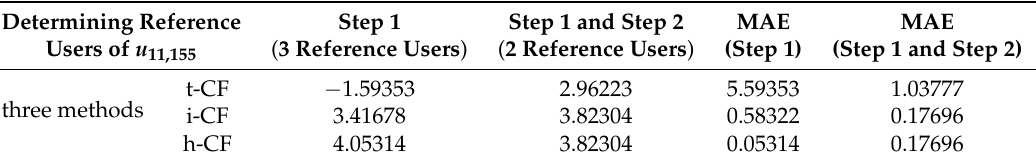
Table 3. Rating prediction results of three methods for u 11155 to i 3588